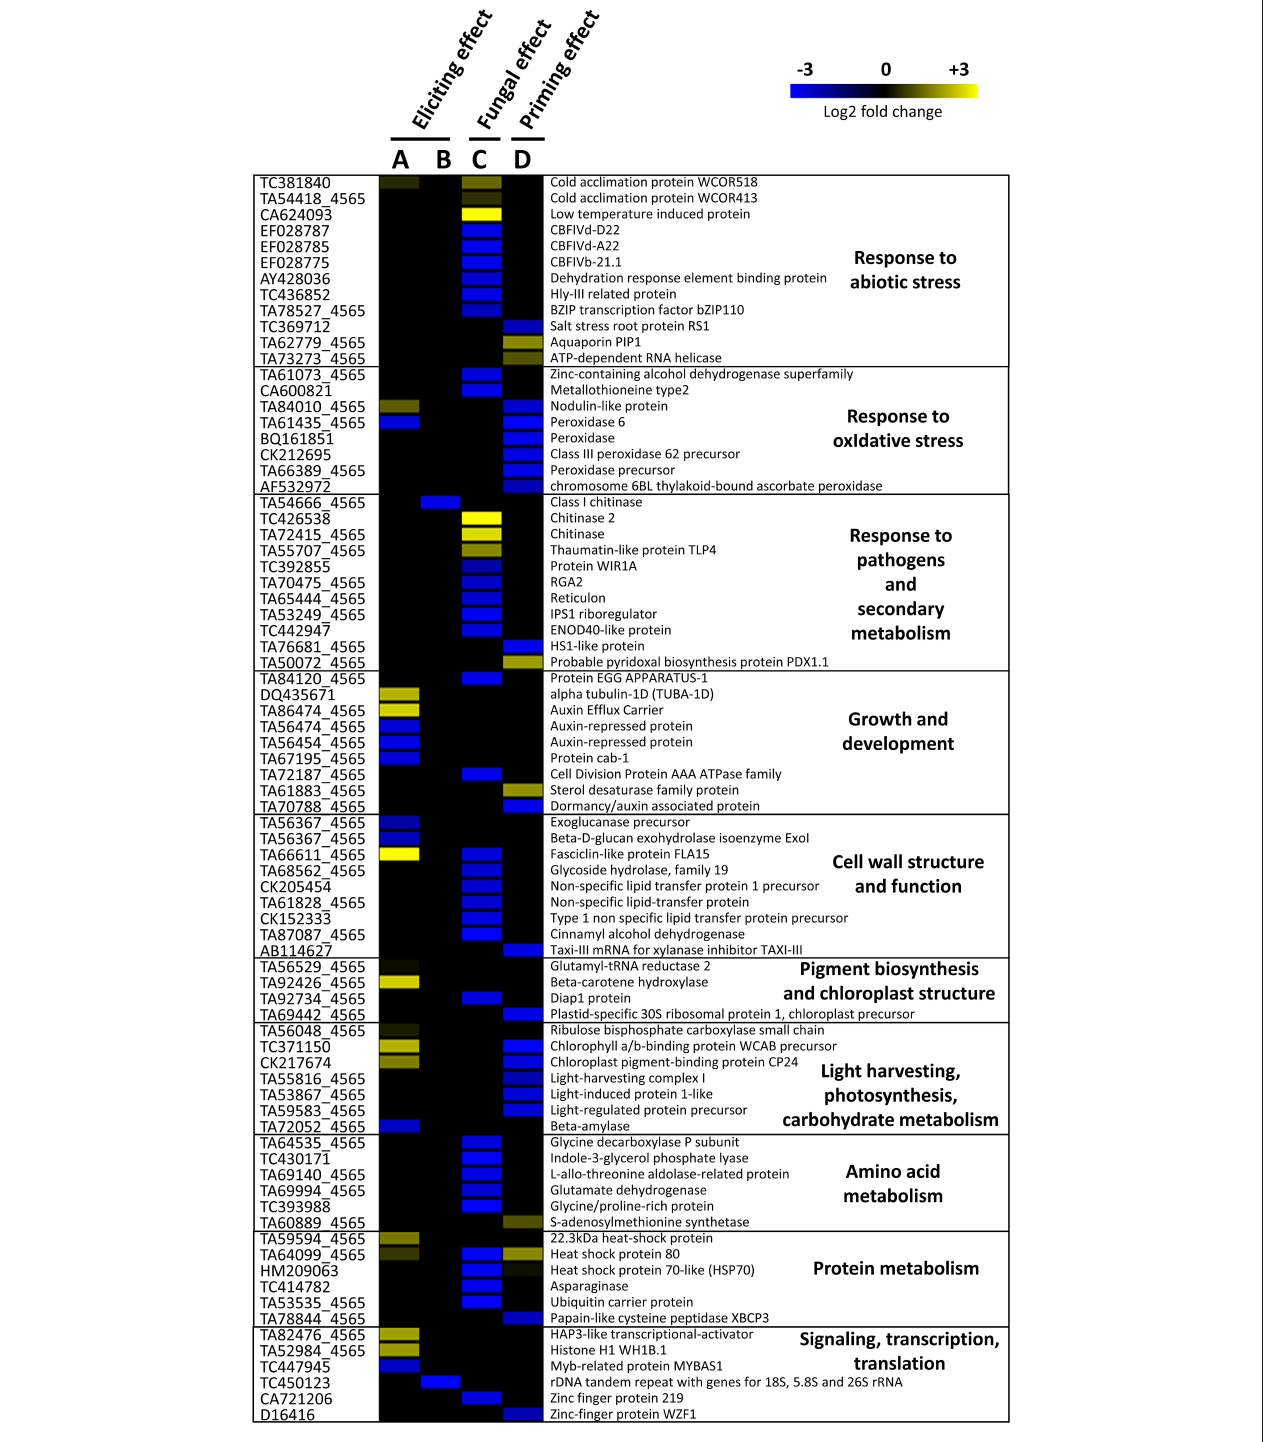
FIGURE 3 | Heatmap representation of differentially expressed genes in wheat leaves (Cv. Alixan) in response to foliar application of 500mg.L − 1 Rh-Est-C12 and/or inoculation with Z. tritici (T02596 strain) (A) 2 and (B–D) 5 days after treatment. Columns (A) and (B) illustrate the effect of the rhamnolipid without further inoculation with the fungus, i.e., the eliciting effect, respectively, 2 (R-D2-Ni vs. C-D2-Ni) and 5 days (R-D5-Ni vs. C-D5-Ni) after treatment. (C) Represents the fungal effect alone (C-D5-i vs. C-D5-Ni), while (D) shows the potential priming activity of Rh-Est-C12 (R-D5-i vs. C-D5-i). Gene-related physiological processes are represented on the right part of the heatmap and were determined using NCBI, AmiGO 2 Gene Ontology, KEGG, and UniProt. Significant relative change in gene transcription is expressed in the Log2 ratio, according to the yellow-blue color scale using the WebMev software. C stands for a mock treatment, while R is for Rh-Est-C12 application; Ni relates to mock-inoculated wheat, while i means inoculated plants with Z. tritici ; D2 or D5 indicates sampling dates of the third leaves, corresponding to 2 or 5 days after treatment, respectively.